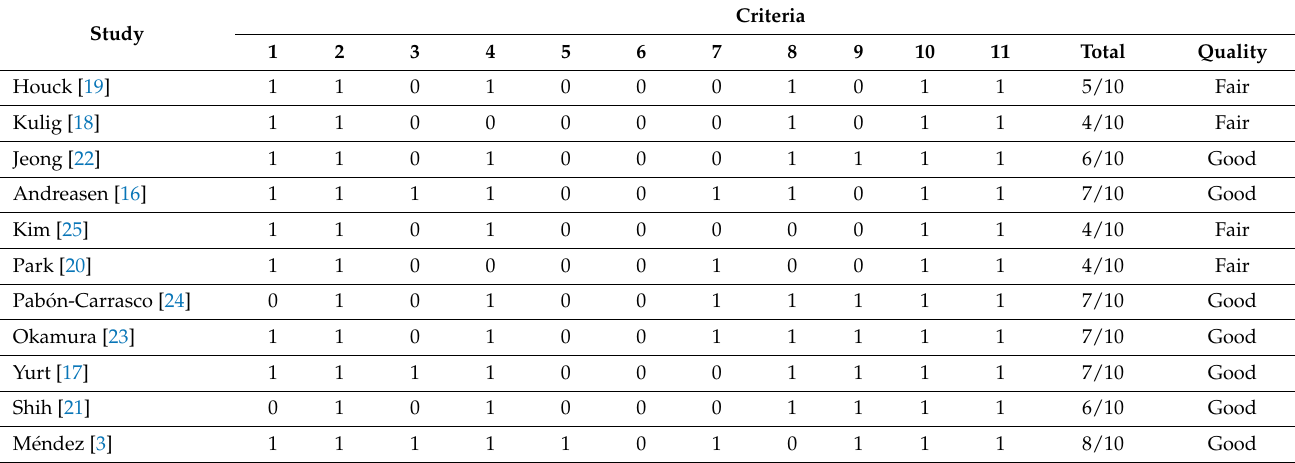
Table 7. Quality of examined studies by Physiotherapy Evidence Database